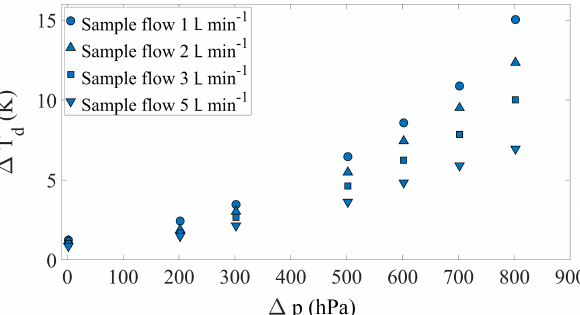
Figure A2. Drying efficiency of one Nafion diffusion dryer, plotted as the difference (cid:49)T d of the dew point temperatures measured in the sample air before and after the Nafion tube. The drying efficiency increases with the pressure difference (cid:49)p between the sample air and the counterflow air and decreases with the sample